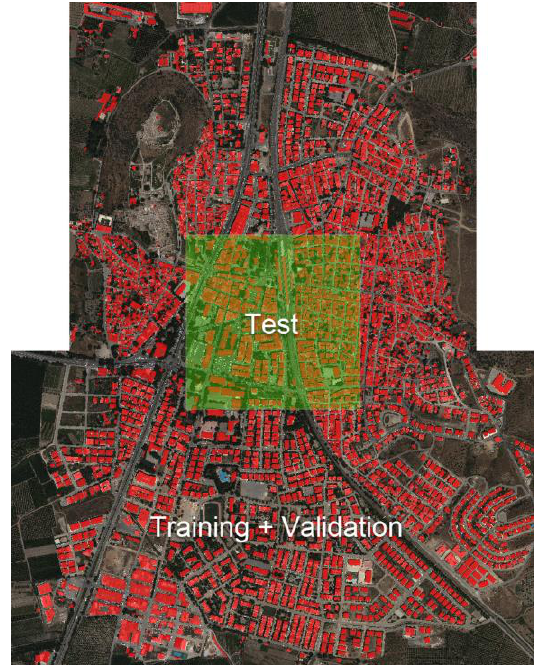
Figure 1 . An overview of the study area with the building footprints (red), test area (green), and training and validation data shown on the true orthophoto.